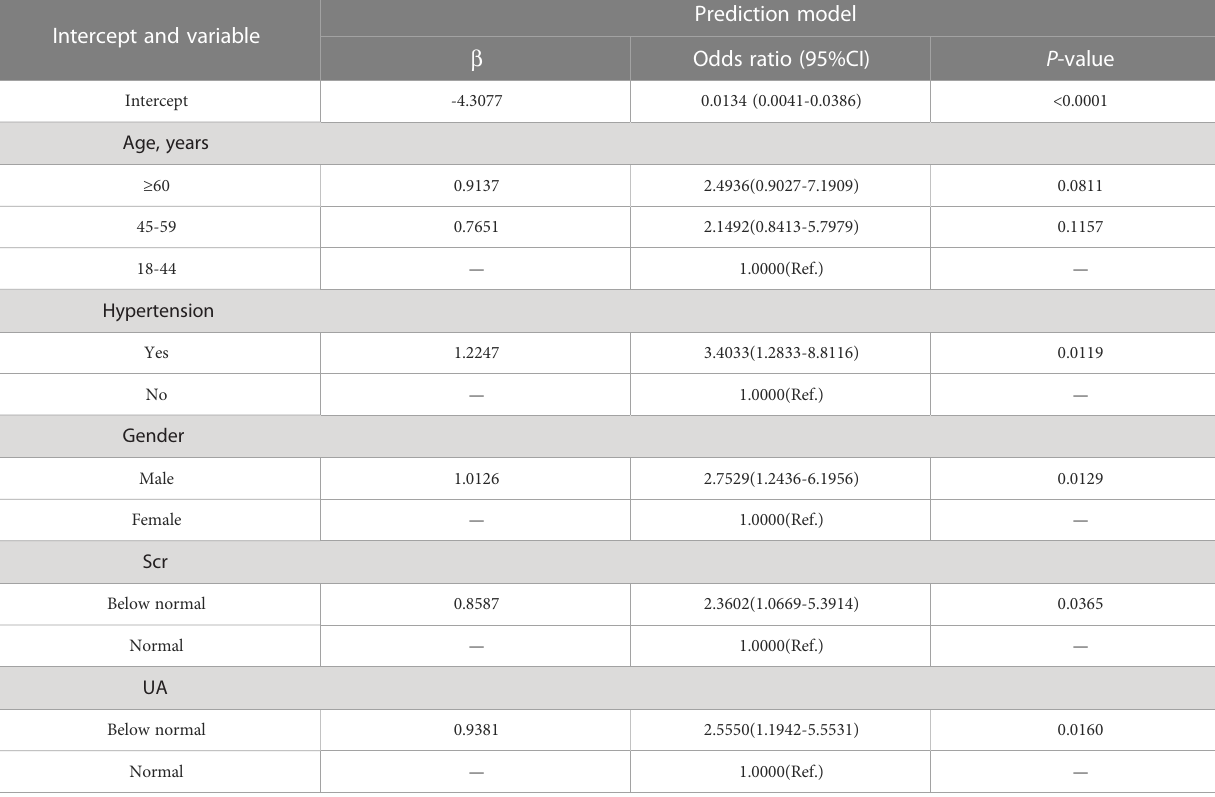
TABLE 3 Multivariable logistic regression model for features of diabetes mellitus.